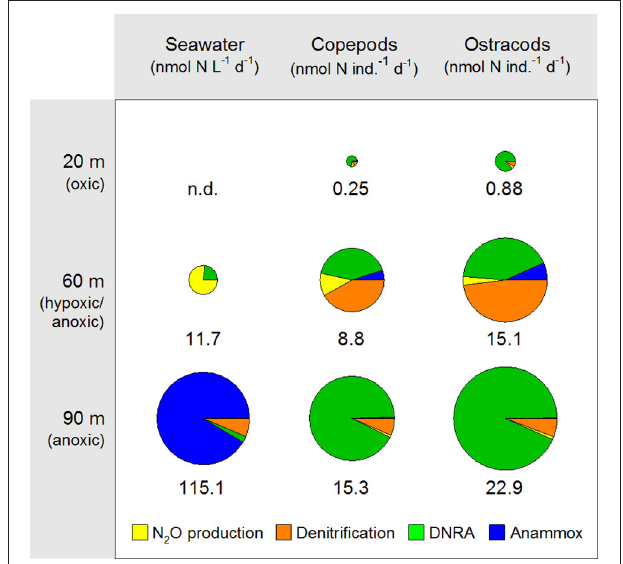
FIGURE 4 | Relative partitioning between N 2 O production, denitrification, DNRA, and anammox in zooplankton vs. seawater incubations. Pie chart area is proportional to the lumped rate of N 2 O production, denitrification, DNRA, and anammox for any given taxonomic group of zooplankton and water depth. The numerical value of the lumped rate is given below each pie chart. n.d., not detected. Note the different units for zooplankton vs. seawater